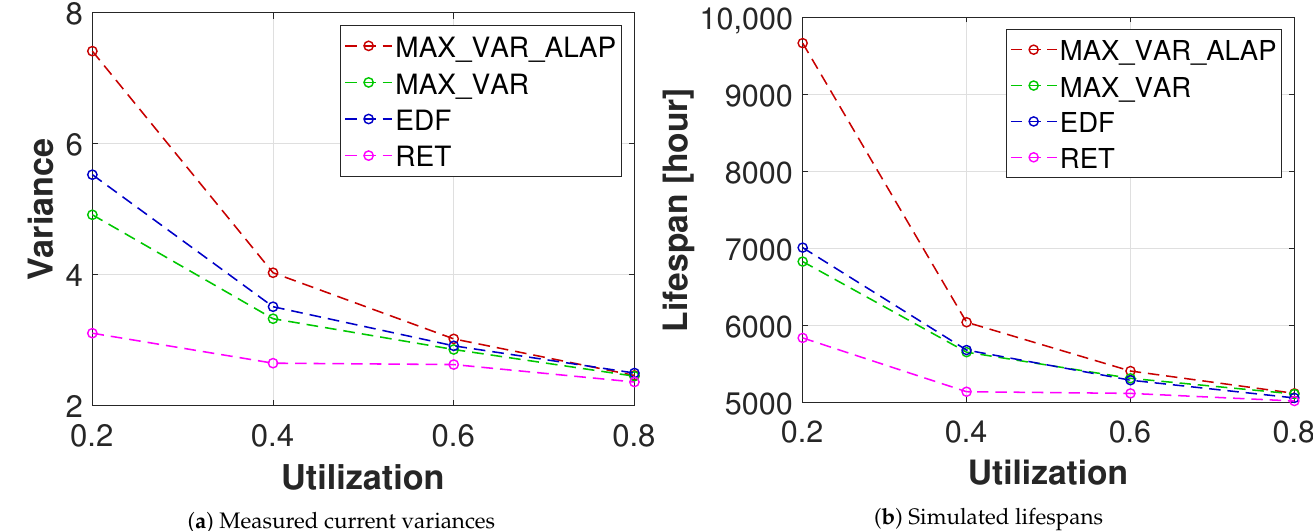
Figure 6. Simulation results of different scheduling